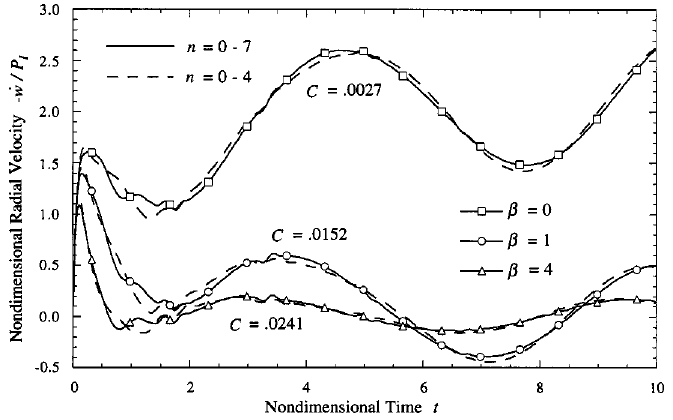
Fig. 4. Shell radial-velocity histories at (cid:18) = (cid:25) for an empty spherical shell excited by plane step-exponential